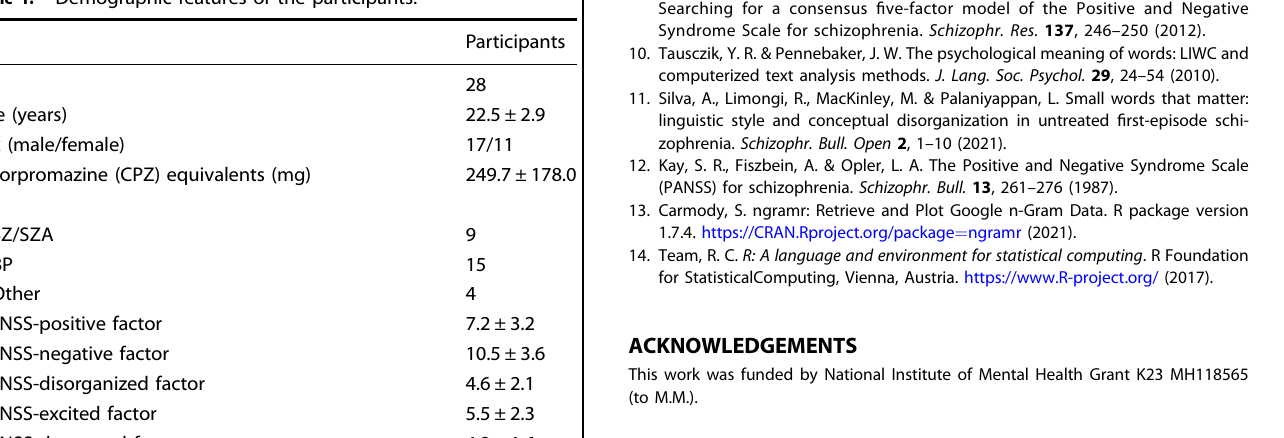
Table 1. Demographic features of the